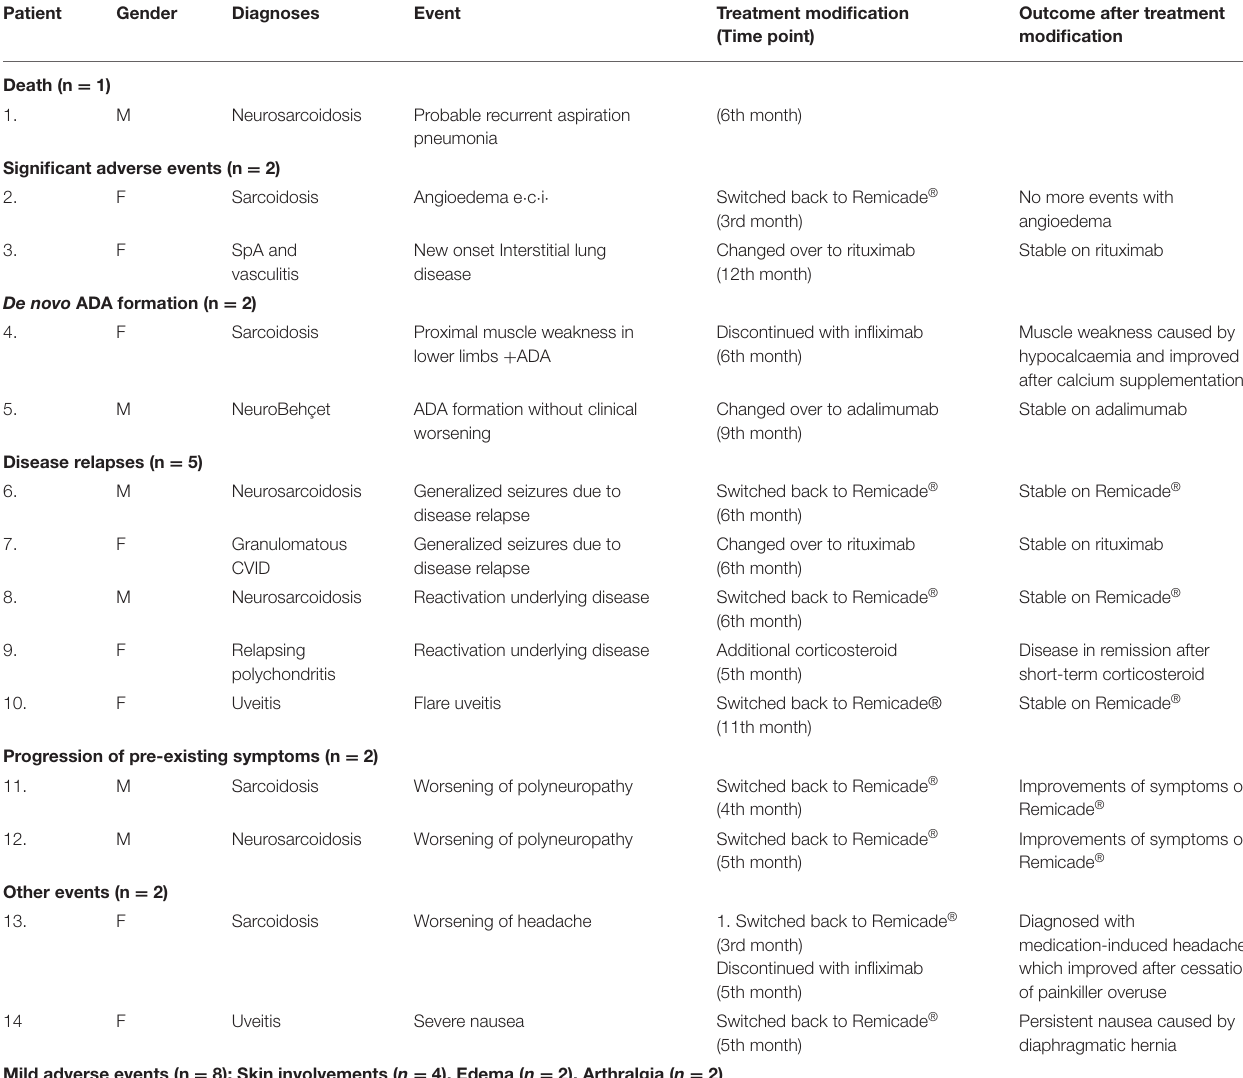
TABLE 2 | Safety monitoring during the first 24